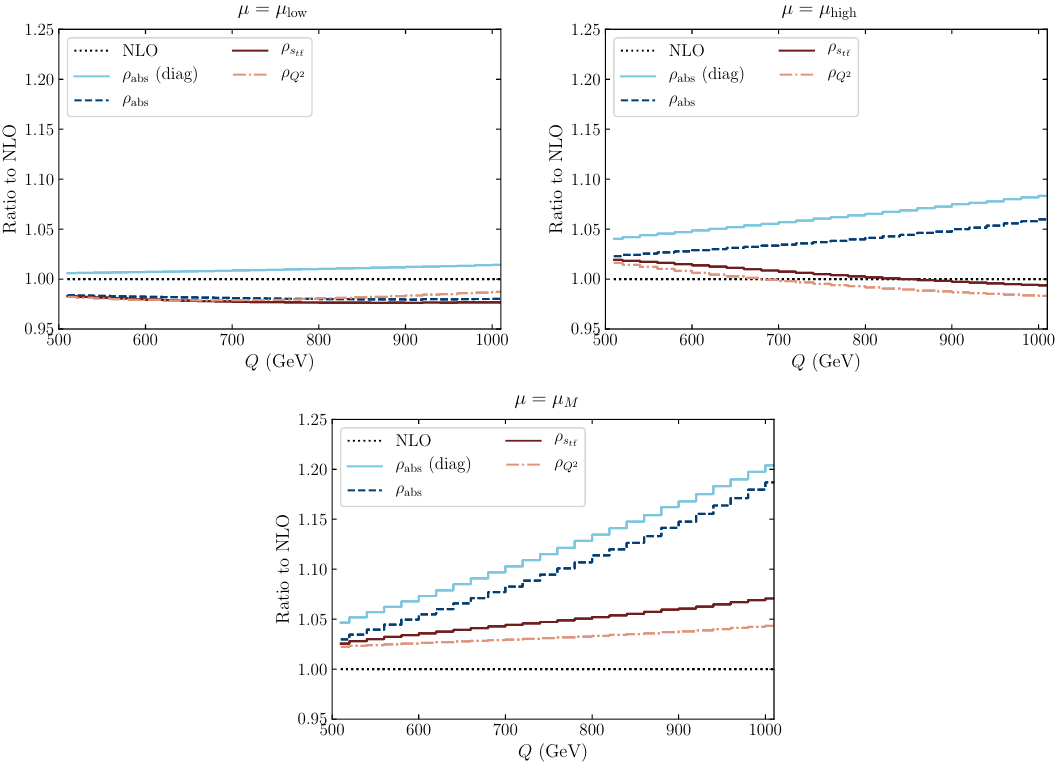
Figure 4 . Ratio of the various resummed invariant-mass distributions to the NLO one for the scale choices µ = µ (upper left), µ = µ (upper right), and µ = µ = Q (below). The ratios low high M obtained using the threshold variable ρ , ρ and ρ are indicated by the dashed dark-blue, solid abs s t ¯ t Q 2 red, and dash-dotted orange lines respectively. The result that is obtained using the approximated soft-anomalous dimension matrix is indicated by the solid light-blue